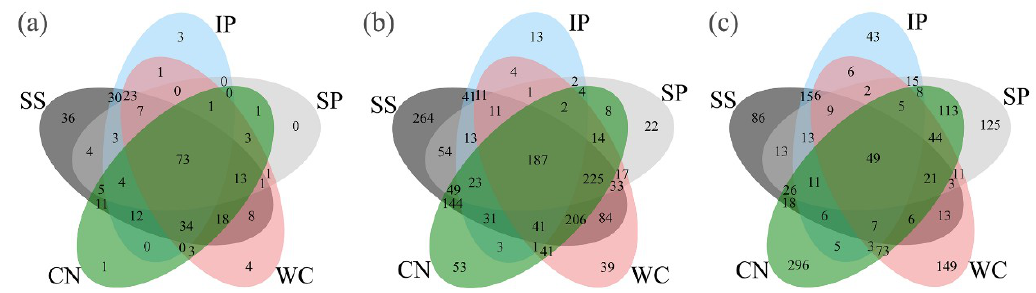
Figure 3. Venn diagrams showing the distribution of fungal ( a ), bacterial ( b ) and diazotrophic ( c ) operational taxonomic units (OTUs) between phyllosphere samples. IP indicates Ipomoea pes-caprae , WC indicates Wedelia chinensis , SS indicates Scaevola sericea , CN indicates Cocos nucifera , SP indicates Sesuvium portulacastrum .